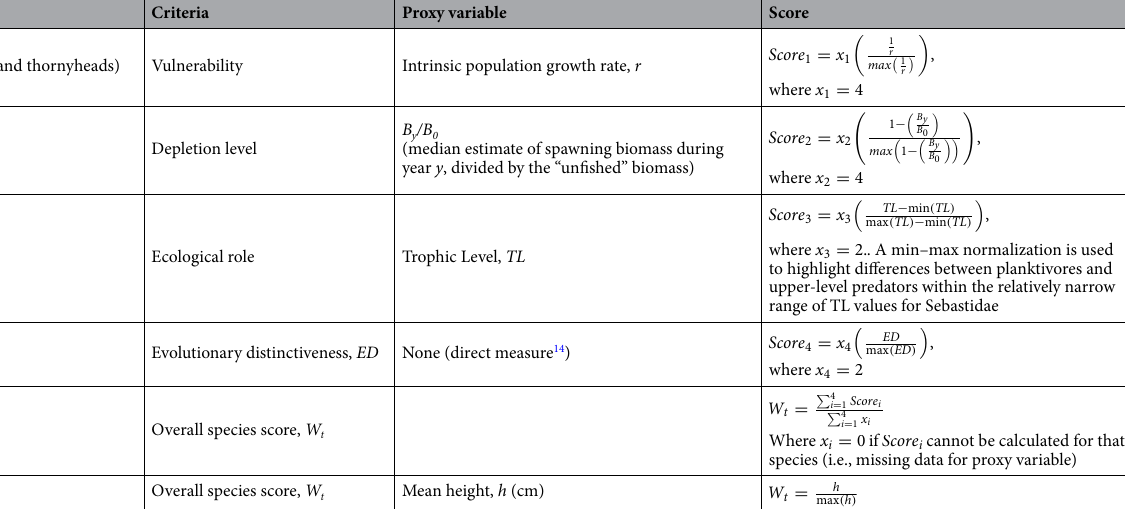
Table 2. Criteria and equations used to calculate the conservation prioritization score, W t , for each species of Sebastidae and for each taxa of structural